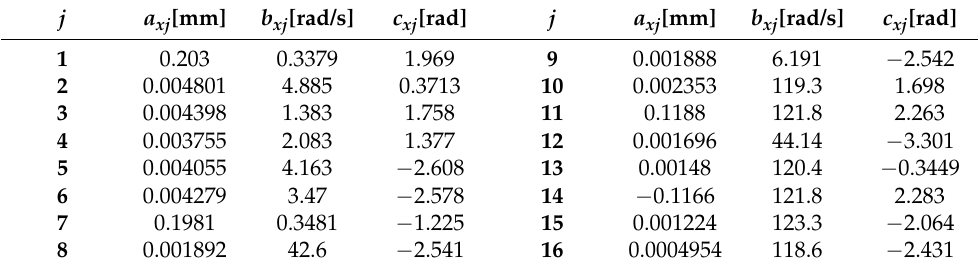
Figure 9. The evolution of an analytical model x aAr (with n = 16) of the average residual x Ar . With n = 16, the values of a xj , b xj and c xj involved in x aAr model from Equation (3) are depicted in Table 1 (as results of x Ar curve fitting). Table 1. The values of a xj , b xj and c xj involved in x aAr model from Equation (3) with n = 16.